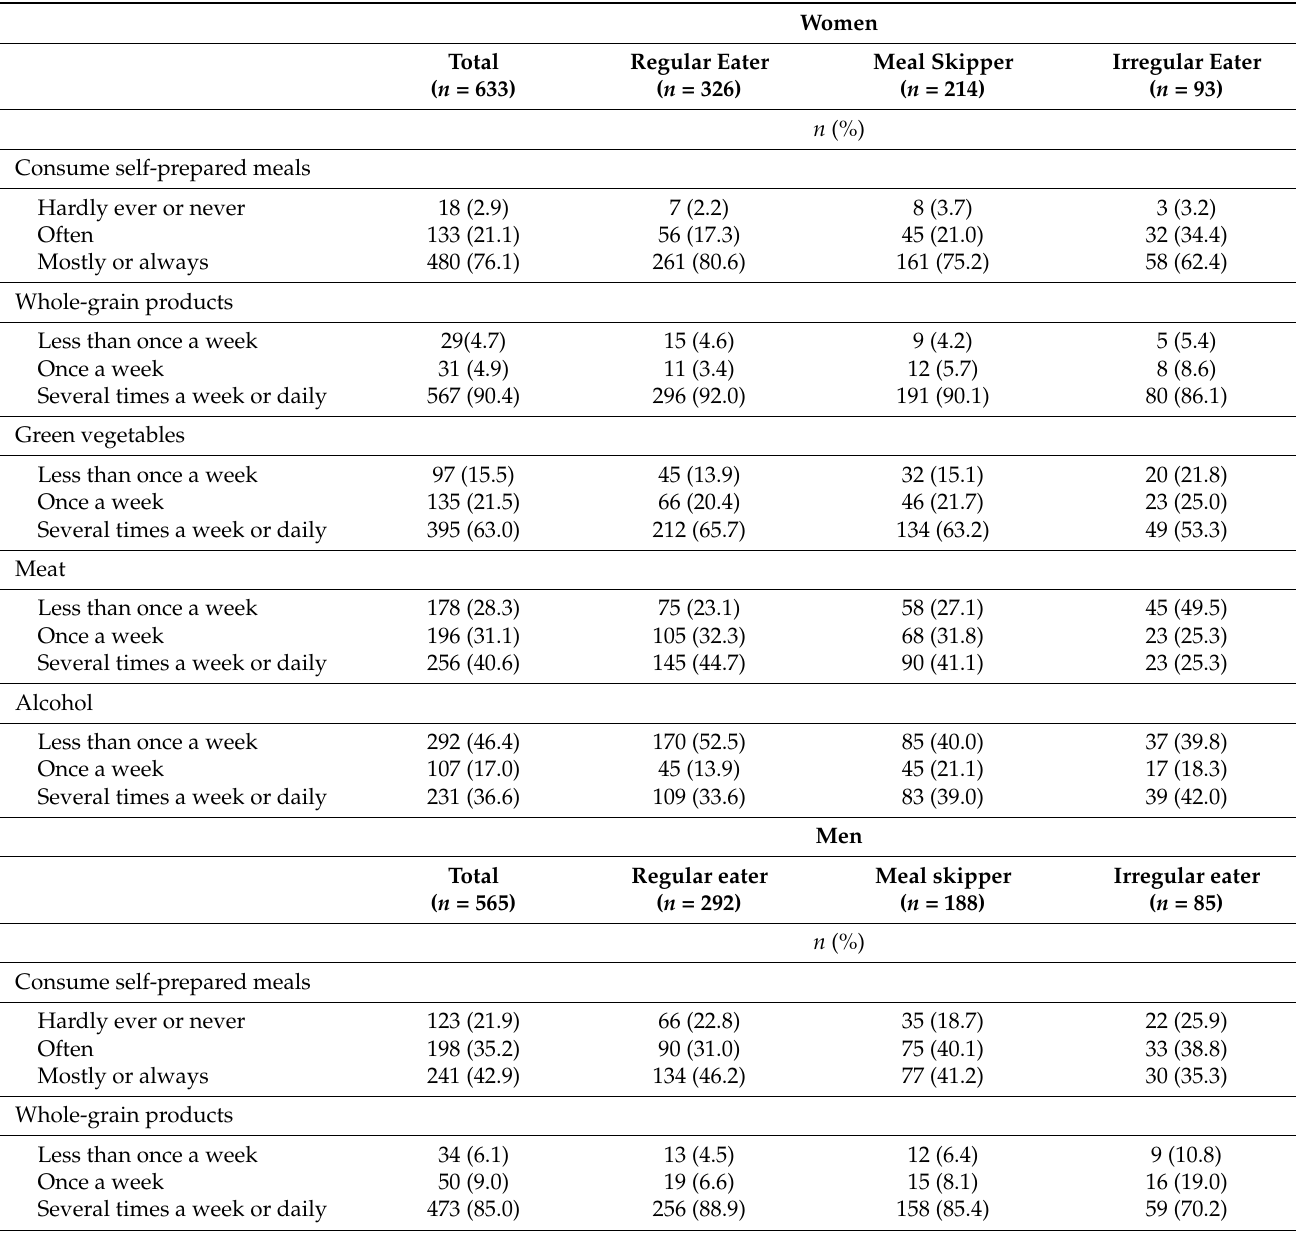
Table 2. Frequencies of consuming self-prepared meals and select food